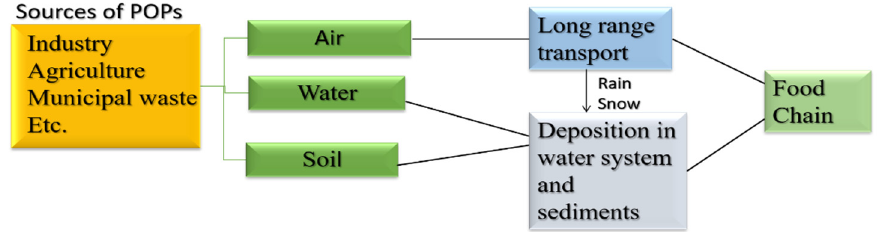
Figure 4. Flowchart representation of flow to POPs in the environment and food chain. Adapted with permission from Ref. [43]. Copyright 2020 Springer Nature.